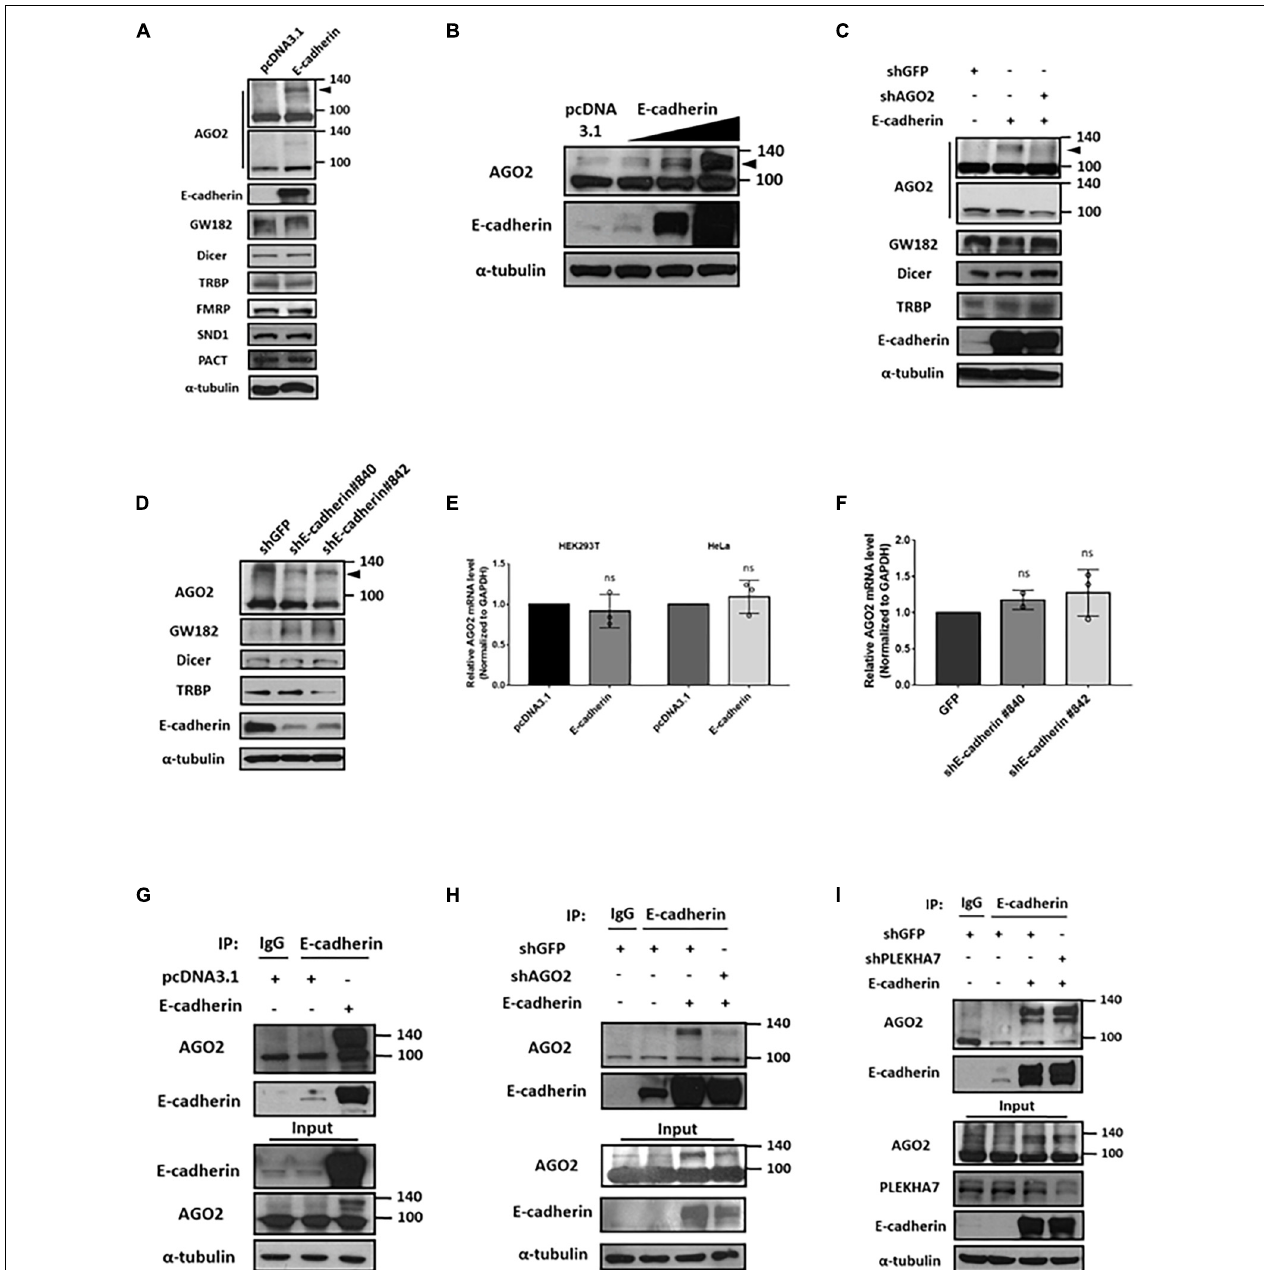
FIGURE 1 | E-cadherin interacts with AGO2 and upregulates its protein expression. Effect of E-cadherin on protein expression of cytoplasmic miRNA biogenesis factors (A-D) . (A) AGO2, GW182, Dicer, TRBP, FMRP, SND1 and PACT protein expression were determined by western blot in E-cadherin-overexpressing HeLa cells. (B) AGO2 were determined by western blot in HeLa cells with sequential increase of E-cadherin overexpression. (C) Effects of AGO2 knockdown on protein expression of AGO2, GW182, Dicer and TRBP in E-cadherin-overexpressing HeLa cells. AGO2 was further knocked down by specific shRNA in E-cadherin-overexpressing HeLa cells. (D) E-cadherin was knocked down in MCF-7 cells using specific shRNAs. Protein expression of AGO2, GW182, Dicer and TRBP were determined by western blot. Effects of E-cadherin on mRNA expression of AGO2 (E,F) . (E) AGO2 mRNA expression was determined by real-time quantitative reverse-transcription PCR (qRT-PCR) in E-cadherin-overexpressing HeLa cells. (F) E-cadherin was knocked down in MCF-7 cells using specific shRNAs. mRNA expression of AGO2 was determined by qRT-PCR. Data were at least repeated in three independent experiments (mean ± SD) and statistically analyzed by two-tailed Student’s t -test (E) and one-way ANOVA (F) . (G) Interaction between E-cadherin and AGO2 in E-cadherin-overexpressing HeLa cells. Immunoprecipitation were performed using anti-E-cadherin antibody. (H) Effects of AGO2 knockdown on the interaction between E-cadherin and AGO2. AGO2 was knocked down by specific shRNA in E-cadherin-overexpressing HeLa cells. Immunoprecipitation was performed using anti-E-cadherin antibody. (I) Effects of PLEKHA7 knockdown on the interaction between E-cadherin and AGO2. PLEKHA7 was knocked down by specific shRNA in E-cadherin-overexpressing HeLa cells. Immunoprecipitation was performed using anti-E-cadherin antibody.